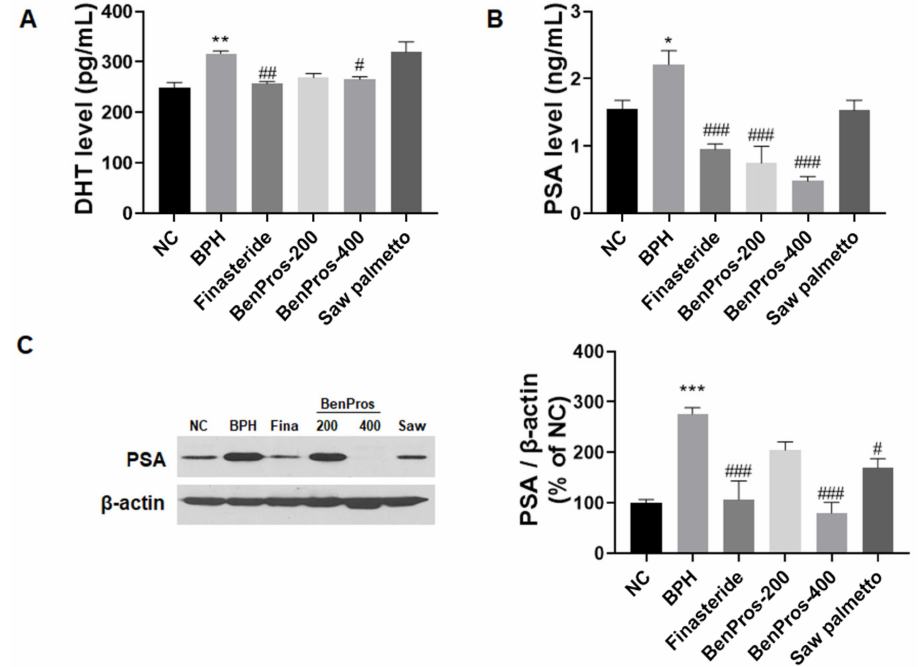
Figure 3. Effect of BenPros on DHT and PSA in BPH rats. ( A ) The serum concentrations of DHT. ( B ) The serum concentrations of PSA. ( C ) Representative western blots of PSA. β -actin was used as an internal control. Blot is normalized to β -actin. Values are presented as the mean ± standard error of the mean of 6 rats per group. * p < 0.05, ** p < 0.01, *** p < 0.001 vs. NC; # p < 0.05, ## p < 0.01 and ### p < 0.001 vs. BPH. Fina: finasteride, Saw: saw